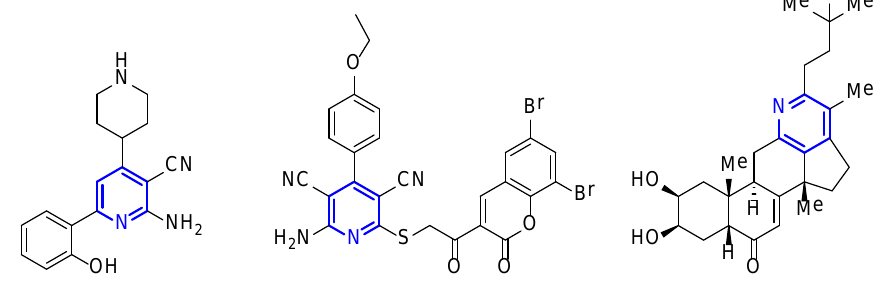
Figure 3. Biologically active pyridine derivatives.